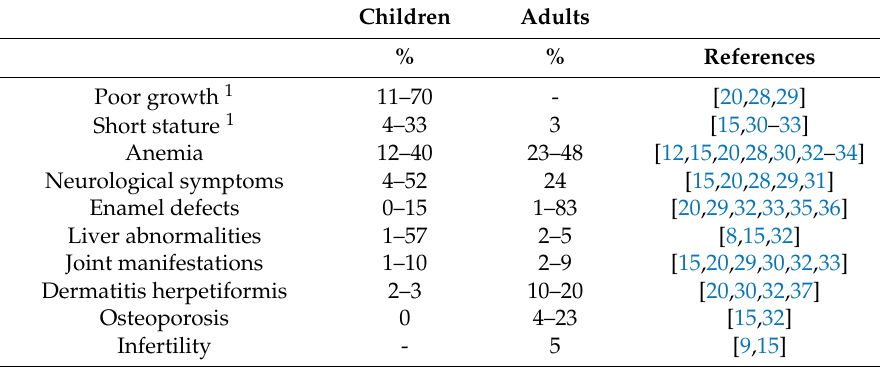
Table 1. Prevalence of the best-characterized extraintestinal manifestations of untreated celiac disease in children and